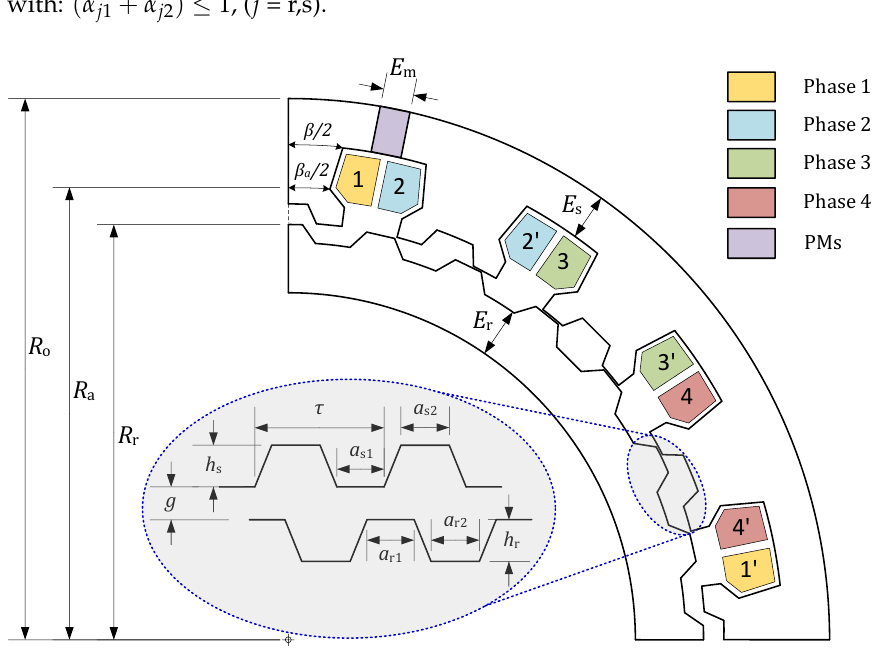
Figure 2. Geometric parameters of teeth and statoric salient poles of the studied machines. The permanent magnets are placed in stator yoke and provides the field excitation. The proposed machines use a double-layer concentrated winding, where each coil is wound around a stator salient pole. Therefore, two layers of windings corresponding to two adjacent phases are located in each stator slot. So the winding of one phase is obtained by connecting two concentrated coils in series or four concentrated coils in series for the first and second studied structures, respectively. The TDSPM machines are considered to be supplied by rectangular current waveforms, where each phase is supplied successively, as shown in Figure 3.